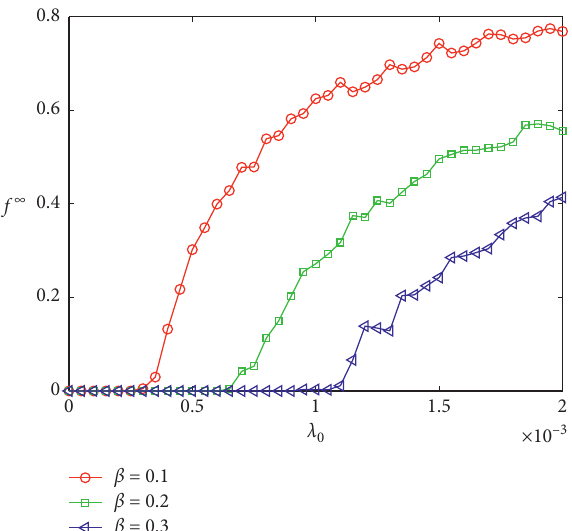
Figure 3: The final infected density f ∞ changes with λ increase of λ , the final infected density f ∞ increases gradually. 0 Parameters are set to be p � 0 . 5, α � 0 . 1.